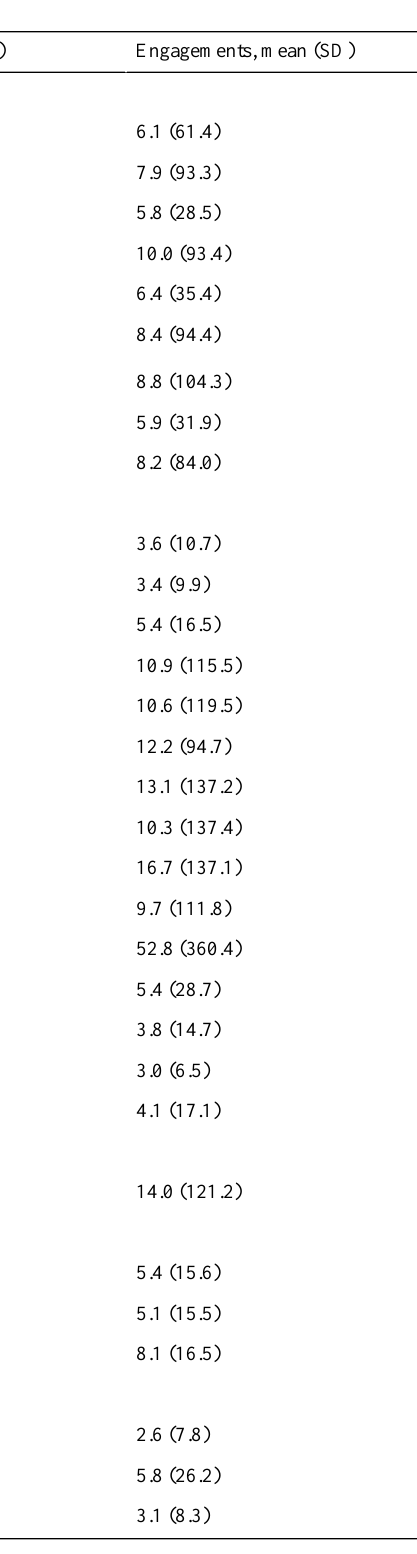
Table 2. Followers and engagements of COVID-19 vaccine–related tweets in 2020. Vaccine